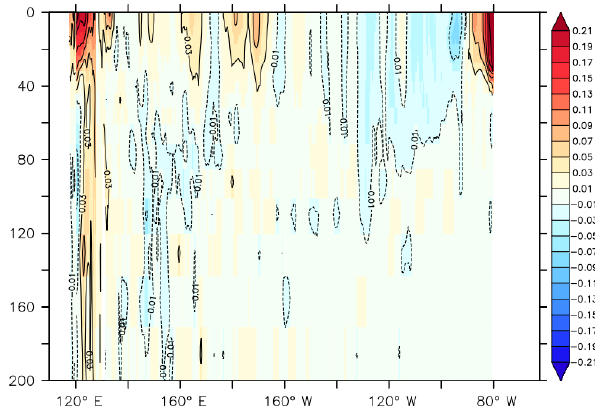
Figure 10. Vertical section along the Equator of the mean model salinity difference between the SMOSexp and REF experiments for the year